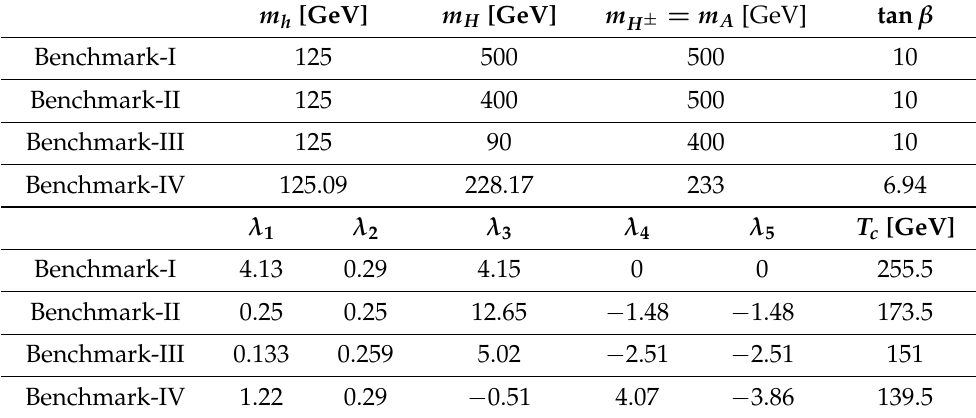
Table 1. 2HDM benchmark points for entropy